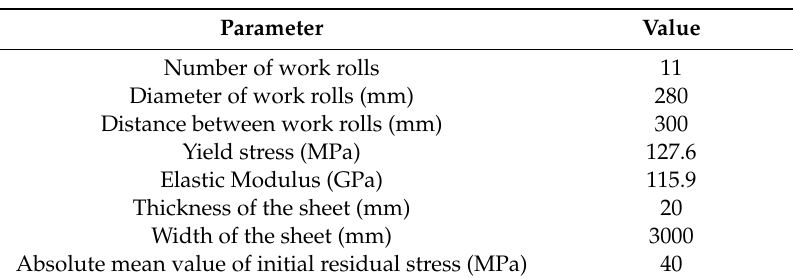
Table 1. Multi-roll levelling